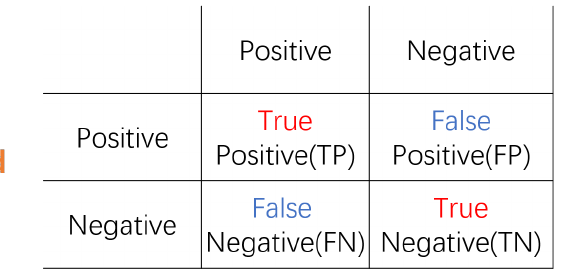
Figure 8. Confusion